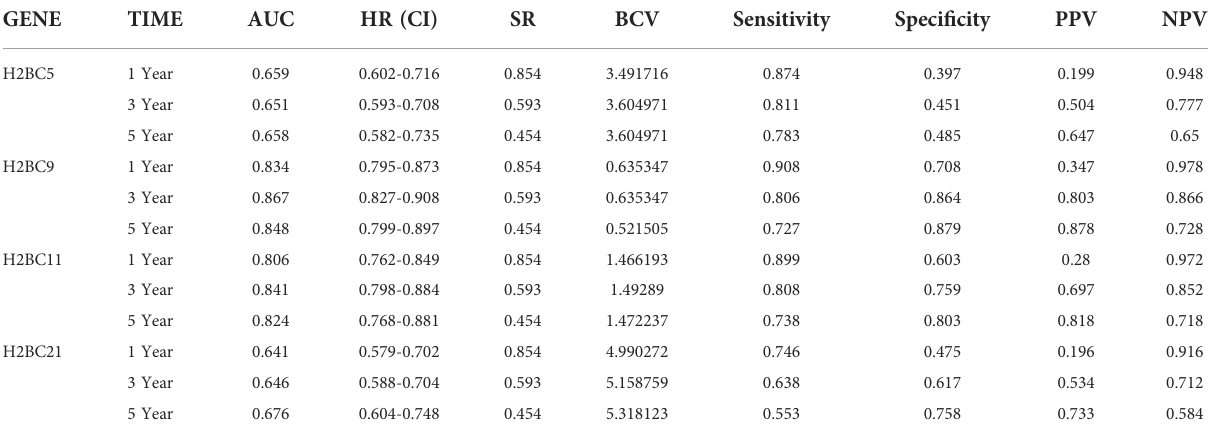
TABLE 2 ROC curve of H2B